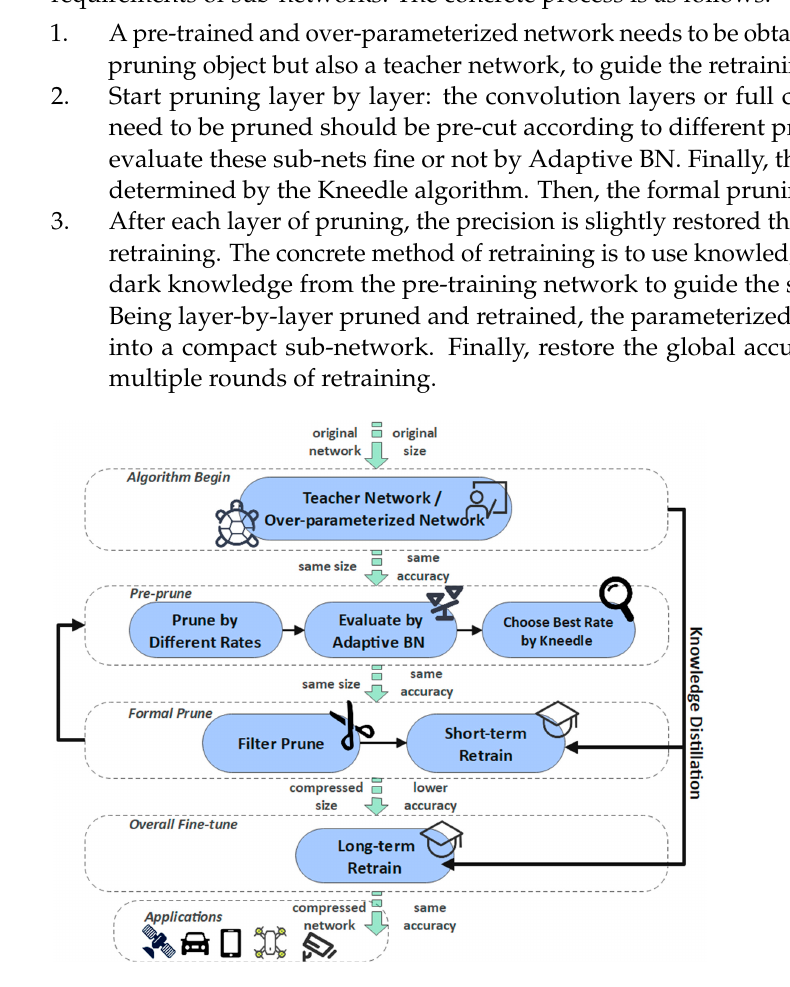
Figure 7. The workflow of Combine-Net.